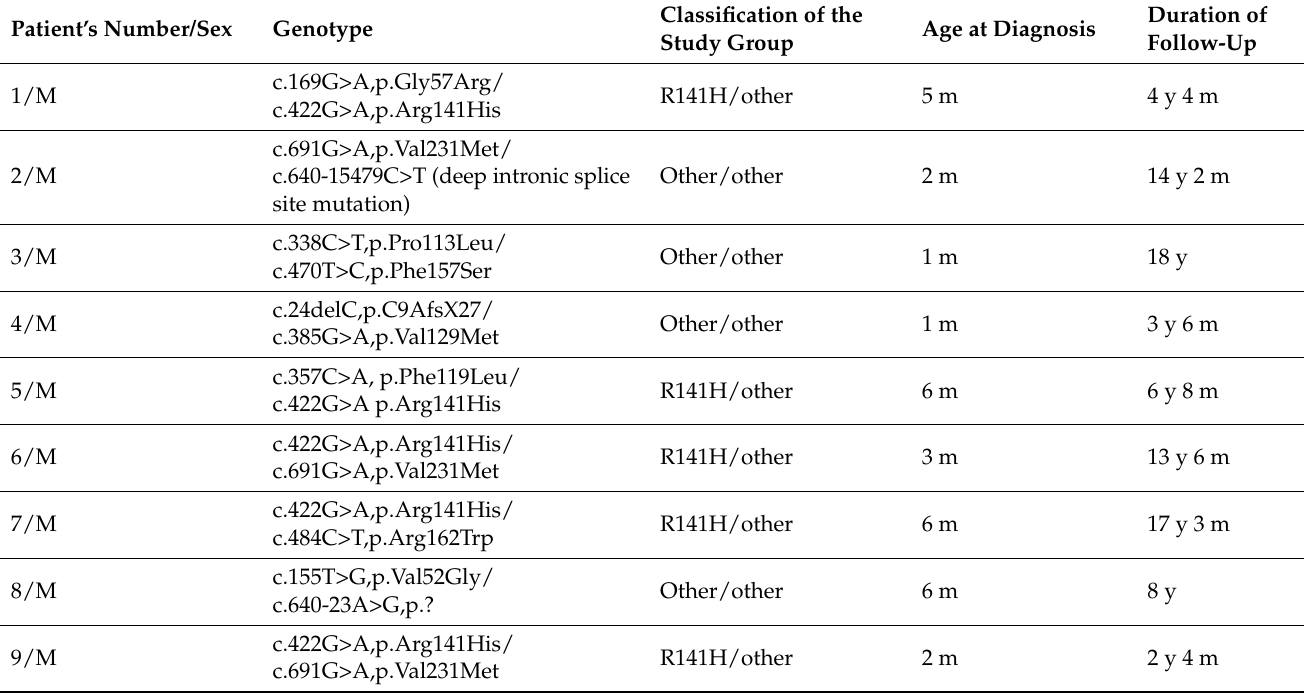
Table 1. Characteristics of the study